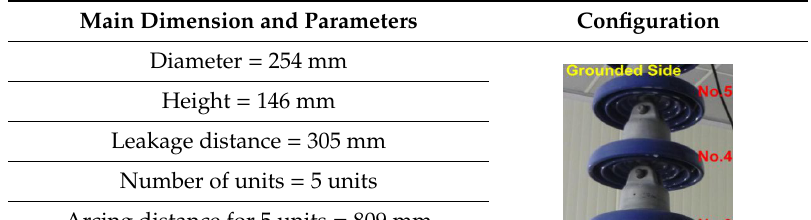
Table 1. Configuration, dimensions, and parameters of each unit of the test specimen. Main Dimension and Parameters